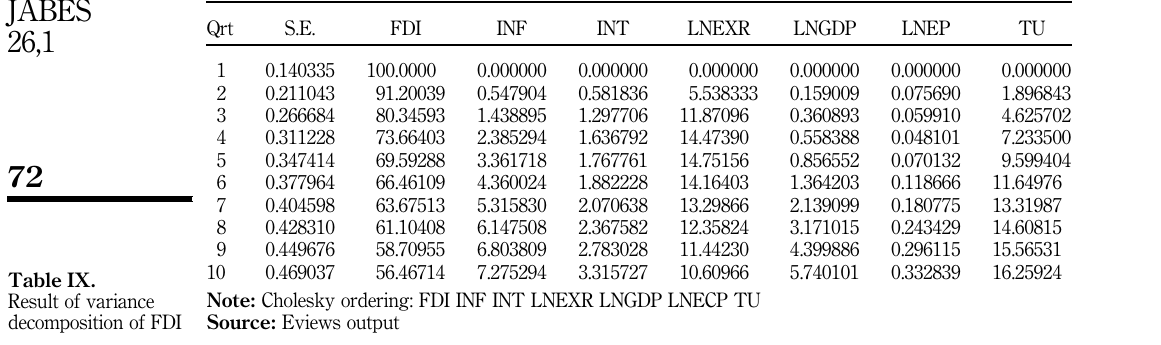
Table IX. Result of variance decomposition of